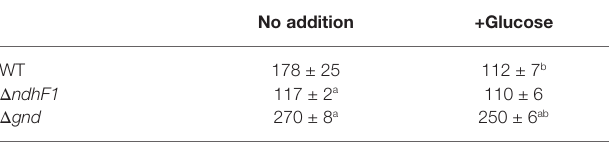
TABLE 1 | Time to reach 93% of the P-level in ms (T peak ).